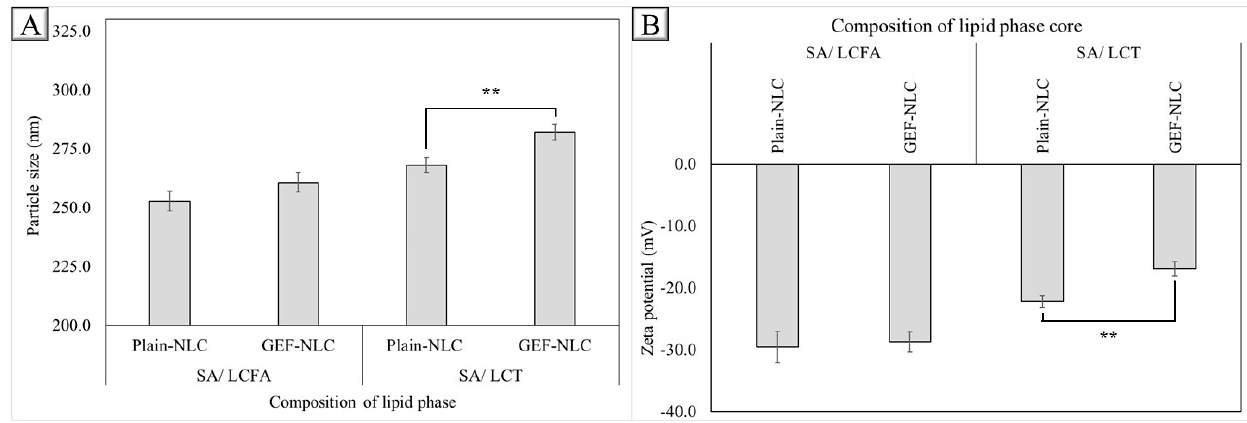
Figure 5. Influence of GEF loading on ( A ) PS and ( B ) ZP of different plain NLC formulations. Data were expressed as the mean ± SD, N = 3, p -value significant at ** 0.01. Table 6. Drug content and EE% of GEF-NLC (LCFA) and GEF-NLC (LCT) .